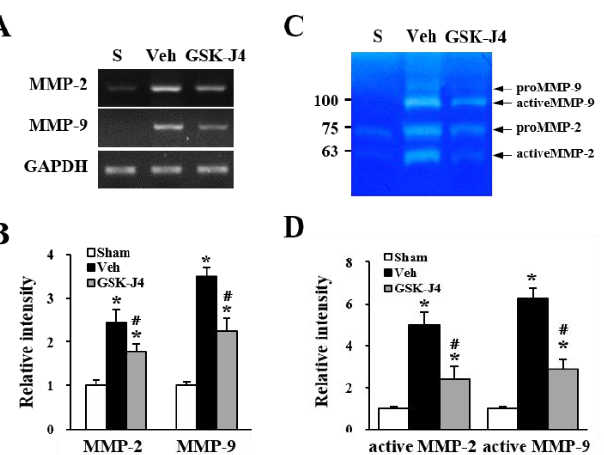
Figure 5. Jmjd3 regulates the expression and activity of MMP-2/9 in the cauda equina after a compression injury. At 30 d after compression injury, GSK-J4 or vehicle-treated cauda equina were prepared 30 min after drug injection and RT-PCR and gelatin zymography were assessed. ( A ) RT-PCR for MMP-2 and MMP-9. ( B ) Quantitative analysis of RT-PCR (n = 3). ( C ) Gelatin zymography for MMP-2 and MMP-9. ( D ) Quantitative analysis of active MMP-2 and MMP-9 (n = 3). All data are expressed as the mean ± SD. * p < 0.05 vs. Sham; # p < 0.05 vs. Vehicle.